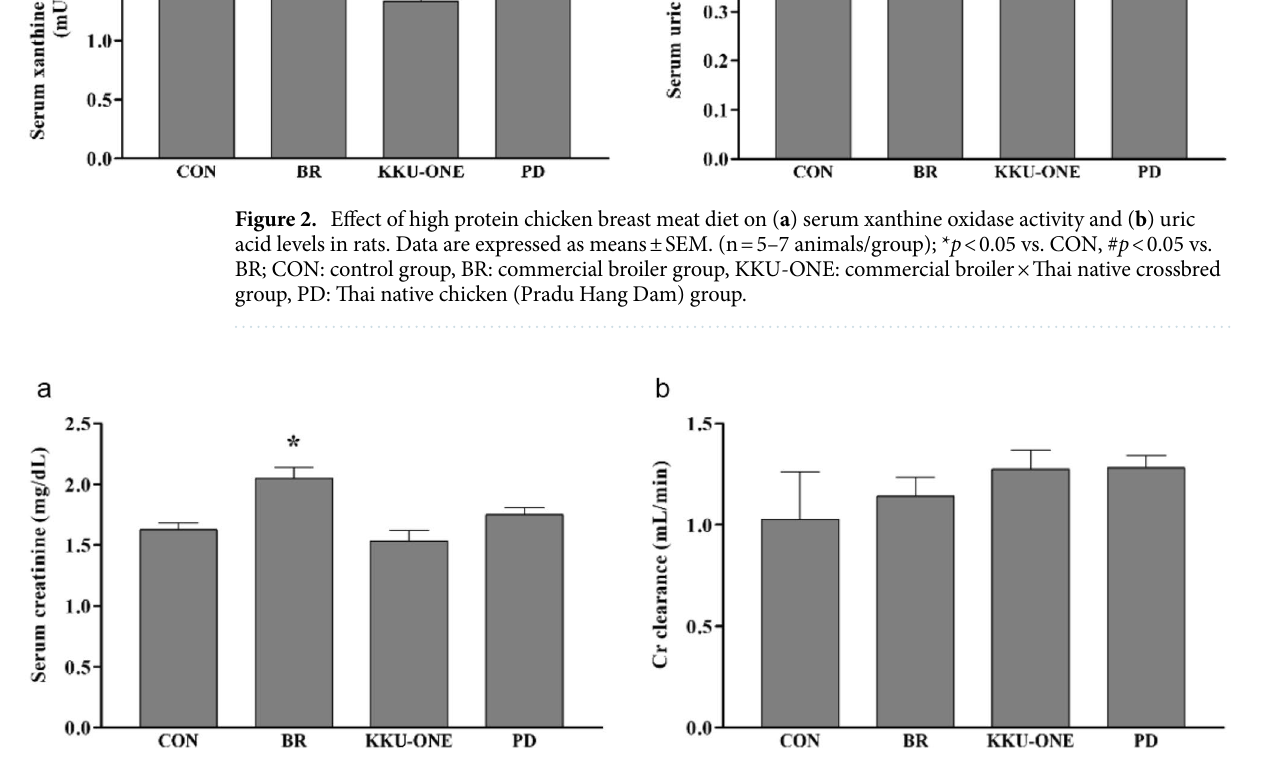
Figure 3. Effect of high protein chicken breast meat diet on ( a ) serum creatinine levels and ( b ) creatinine clearance in rats. Data are expressed as means ± SEM. (n = 5–7 animals/group); * p < 0.05 vs. CON. Cr: creatinine;